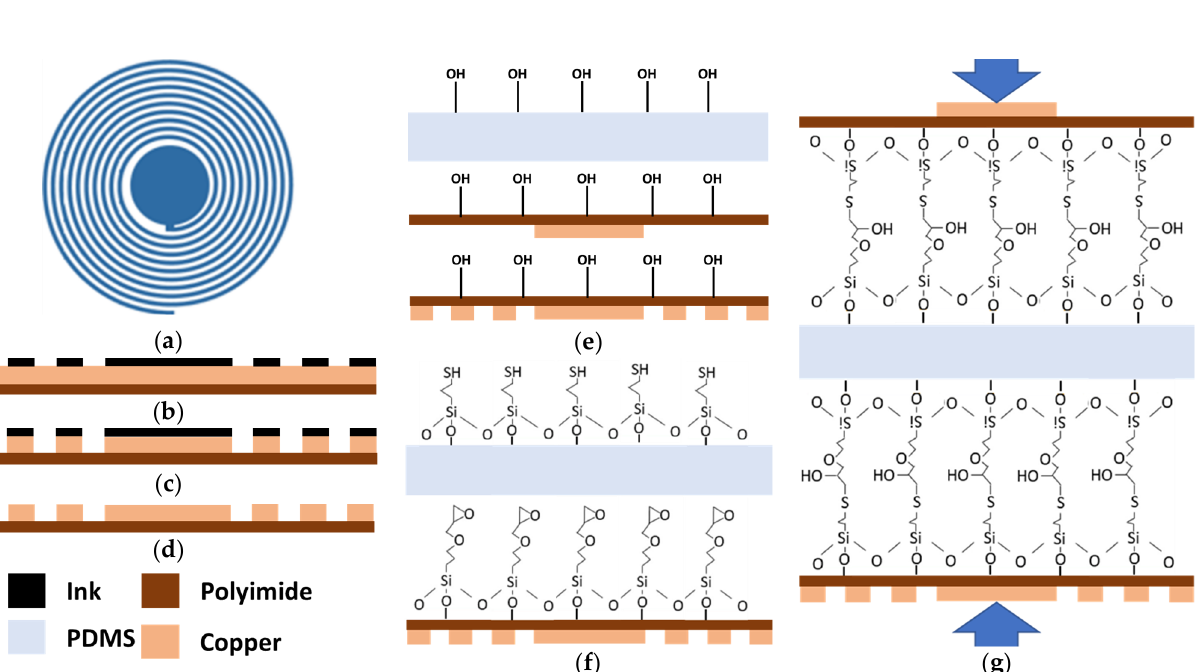
Figure 1. Sensor designing and fabrication process: ( a ) Pressure sensor geometry, ( b ) Ink mask printed on copper-coated polyimide sheet, ( c ) Sensor patterns after etching process, ( d ) Sensor pattern after cleaning with acetone, ( e ) Plasma treatment of PDMS and polyimide, ( f ) Chemical surface functionalization, ( g ) PDMS sandwiched between polyimide sheets to make the final assembly of the sensor under